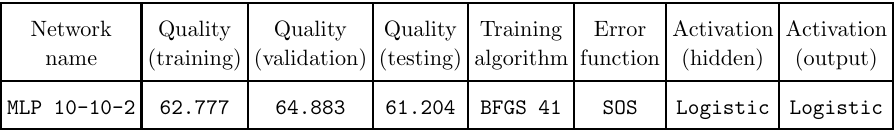
Table 7. Characteristics of the selected artificial neural network (after PCA)